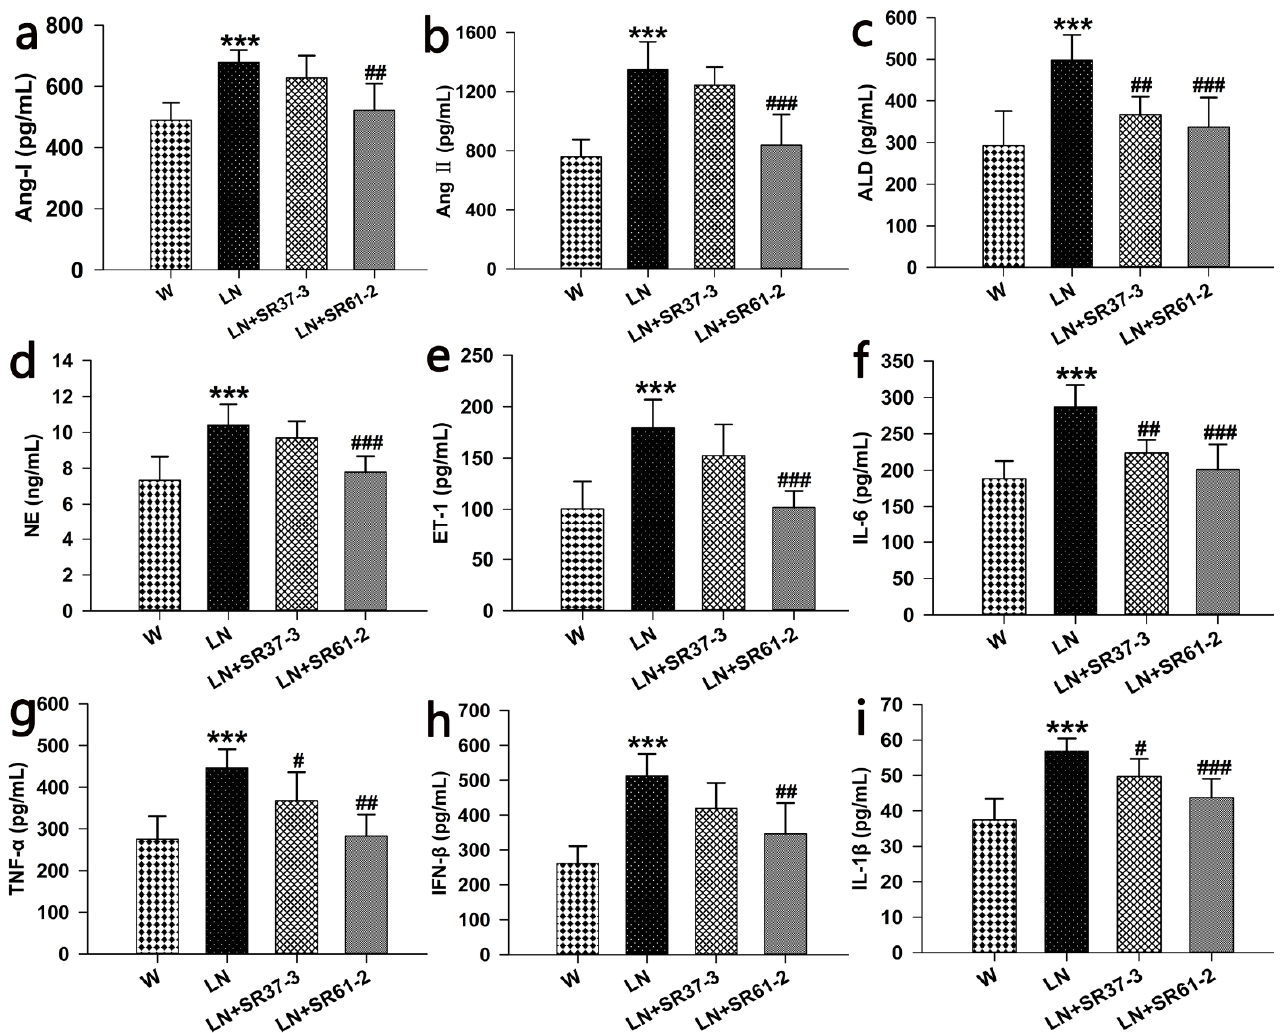
Figure 2. Effects of long-term PFM administration on serum hormones, inflammatory factors and enzymes associated with hypertension. ( a ) for angiotensin I (Ang I), ( b ) for angiotensin II (Ang II), ( c ) for aldosterone (ALD), ( d ) for norepinephrine (NE), ( e ) for endothelin-1(ET-1), ( f ) for interleukin-6 (IL-6), ( g ) for tumor necrosis factor- α (TNF- α ), ( h ) for interferon- β (IFN- β ) and ( i ) for interleukin-1 β (IL-1 β ). Values are expressed as mean ± SD ( n = six rats). *** indicates p < 0.001, compared with the W control group; #, ## and ### indicate p < 0.05, p < 0.01 and p < 0.001, respectively, compared with the L-NAME control group. cont W: animals not treated with L-NAME receiving standard chow; cont LN: L ‐ NAME treated rats receiving standard chow; LN + SR37 ‐ 3: L ‐ NAME treated rats receiving PFM ‐ SR37 ‐ 3; and LN + SR61 ‐ 2: L ‐ NAME treated rats receiving PFM ‐ SR61 ‐ 2.